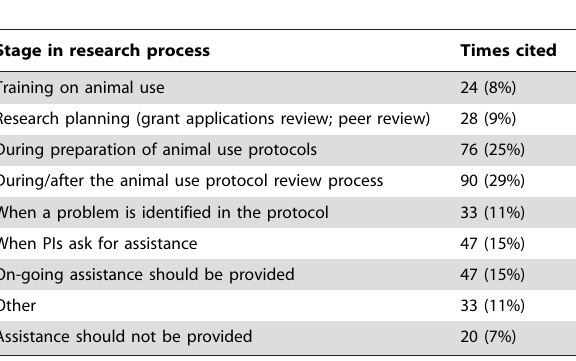
Table 3. Stage in research process where Three Rs-related assistance might be useful and/or acceptable, n=